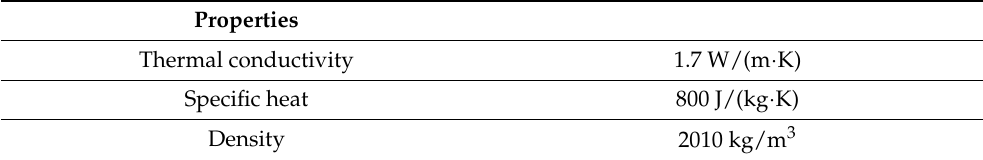
Table 1. Thermal properties of concrete.